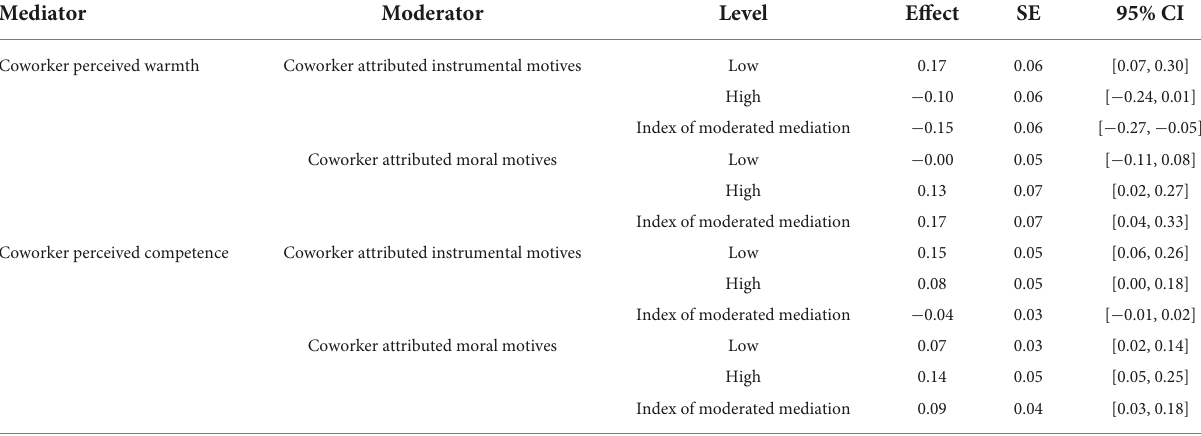
TABLE 4 Conditional indirect